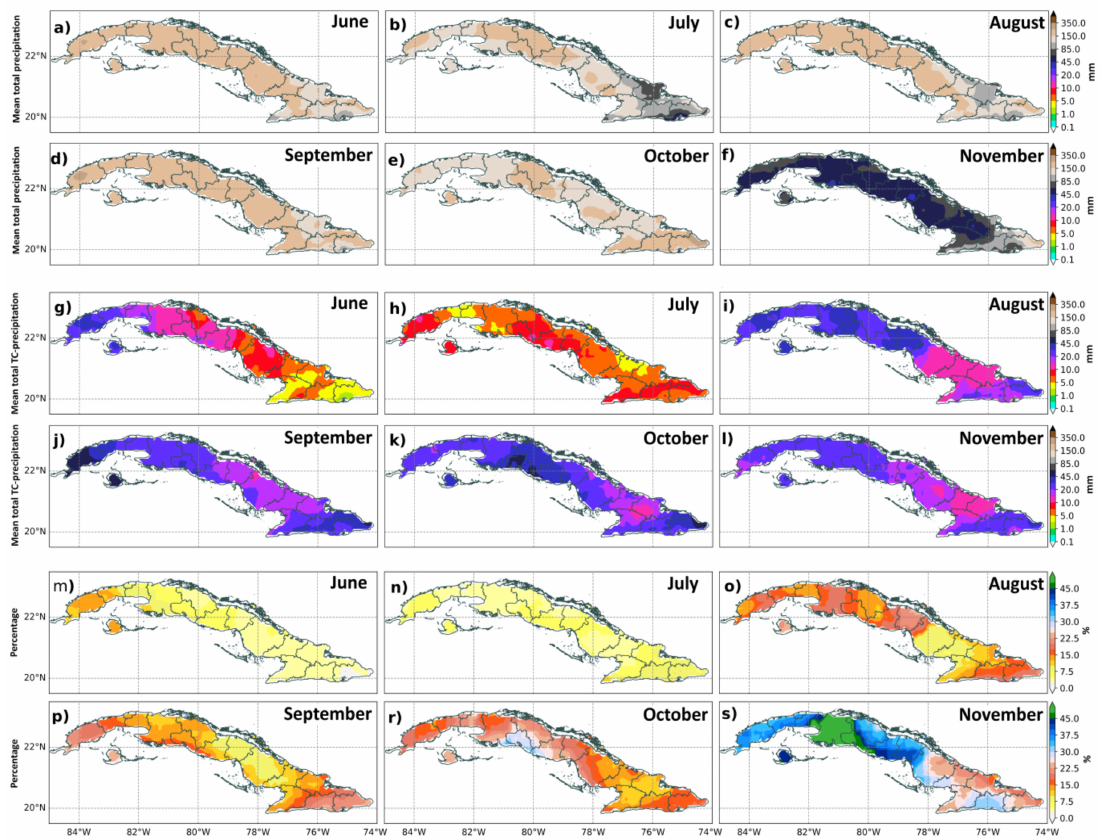
Figure 9. Mean total precipitation ( a – f ), mean total TC–related precipitation ( g – l ), and its percentage values ( m – s ) for June, July, August, September, October and November. Period: